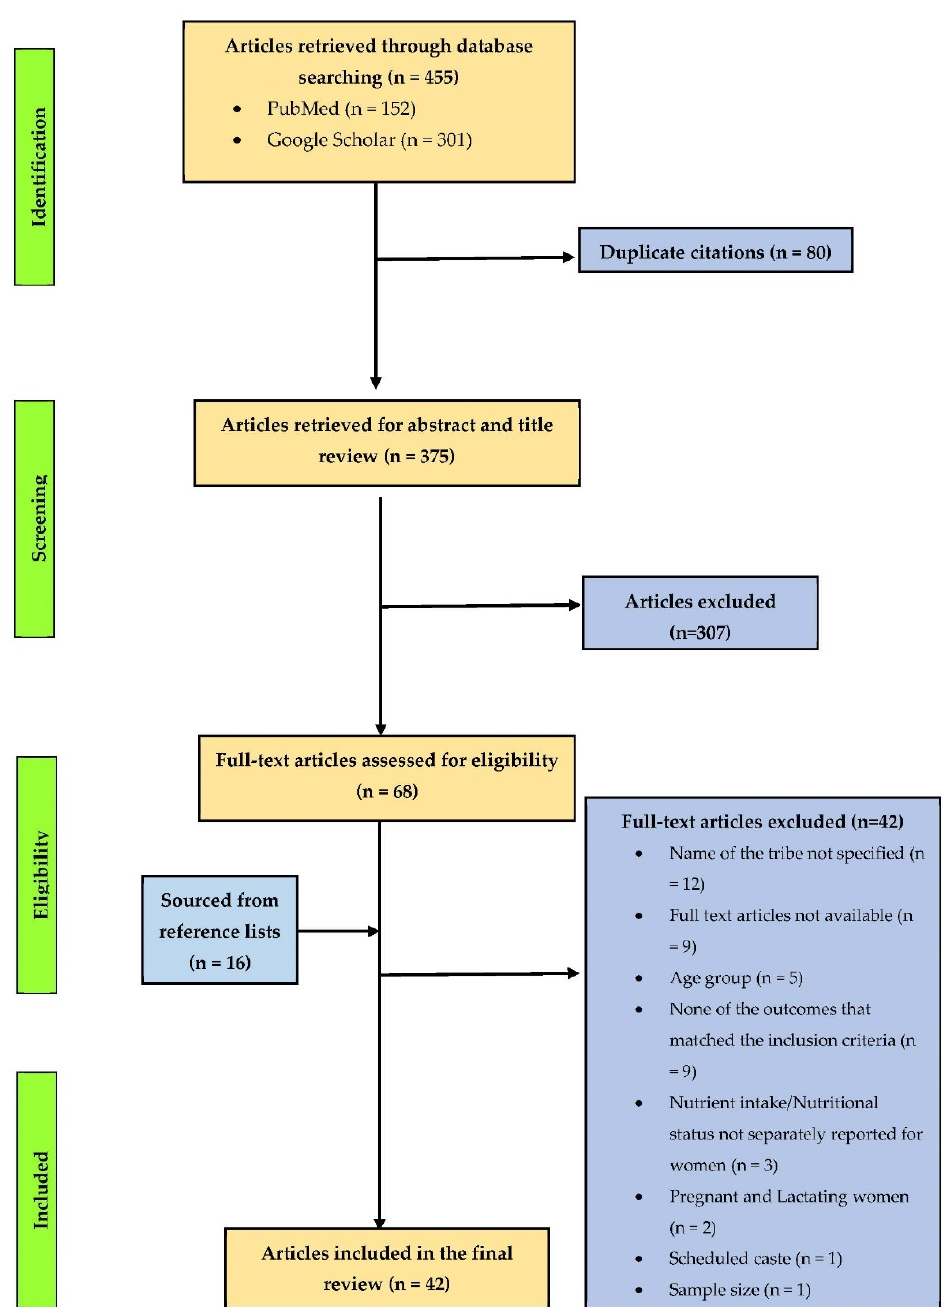
Figure 1. Flow diagram reporting the screening and selection process used in identification